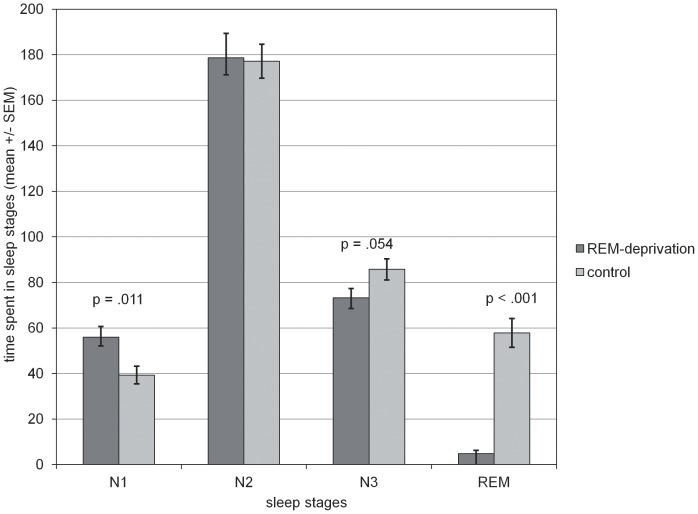
Manipulation check.Minutes in sleep stages N1, N2, N3 and REM sleep (mean ±SEM). Participants in the REM-sleep deprivation condition remained in REM sleep for significantly less time and more in N1 than those in the control group. (* p<.05; ** p<.001).